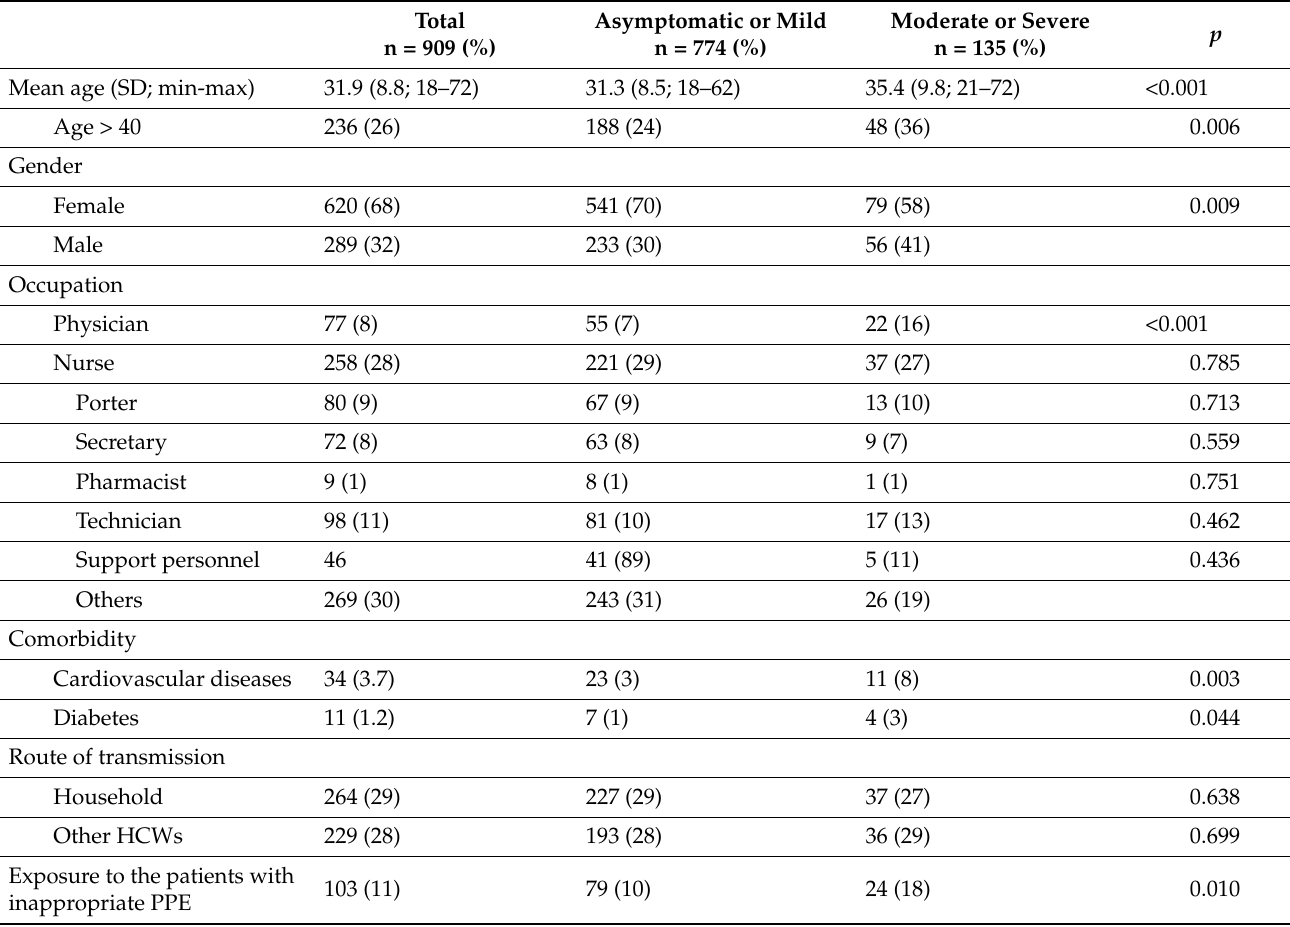
Table 1. Univariate analysis for risk factors of COVID-19 severity.